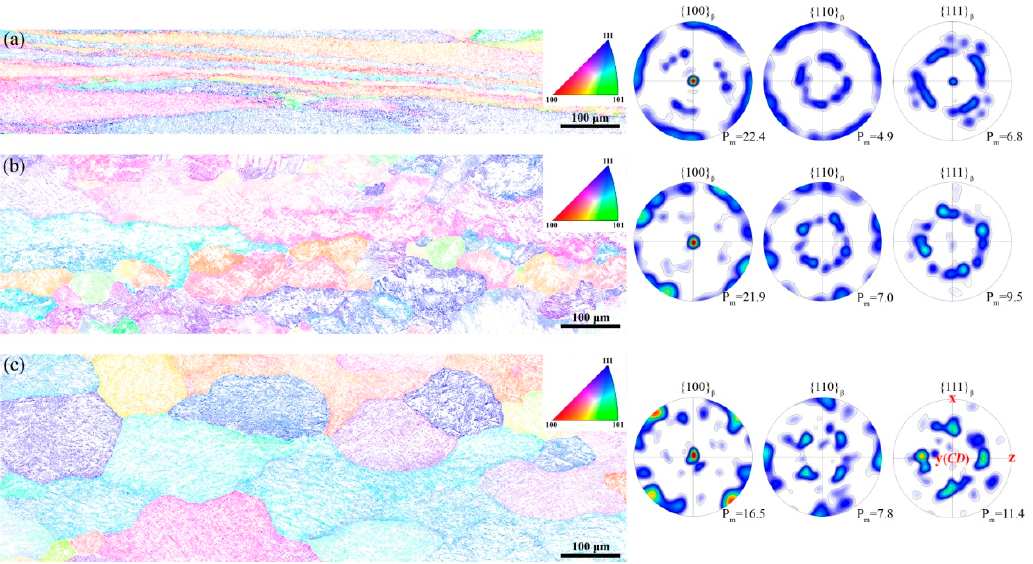
Figure 2. Inverse pole figure maps and the corresponding pole figures for the retained β phase in the samples after deformation at ( a ) 2 s − 1 , ( b ) 0.2 s − 1 , and ( c ) 0.02 s − 1 . The scanning step size is 0.3 μ m. The compression axis is vertical. Note that the coordinate system for the pole figures are indicated, where y denotes the compression direction, x and z are the radial direction of the deformed samples.